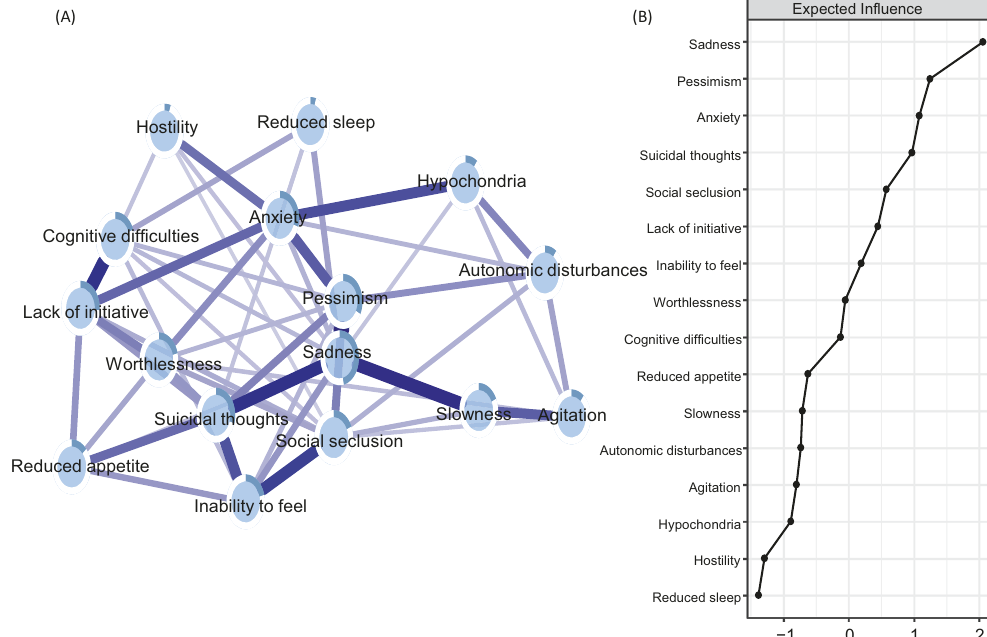
Fig. 1 Network of depressive symptoms (panel A ) and centrality measure of expected in fl uence (panel B ). Blue connections indicate positive correlations; the thickness of lines is proportional to the strength of the correlation. The darker outer circle of each node represents the predictability, i.e., the proportion of variance explained by its neighbouring nodes. Expected in fl uence is the standardized sum of the weights of all direct connections between a speci fi c symptom and all other